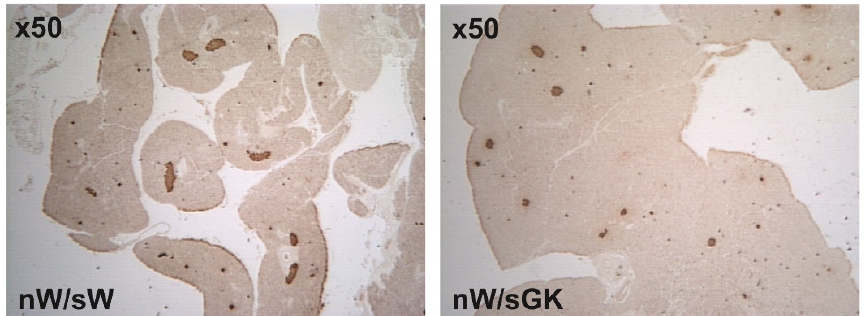
Figure 5. Representative immunoperoxidase staining for pancreatic insulin in 8-wk-old male rats. Animals were issued from W neonates suckled by GK foster mothers (nW/sGK group), or issued from W neonates suckled by W foster mothers (nW/sW group). After glucose administration, their plasma glucose levels and AUC/glucose ( Δ I / Δ G ) raised to levels markedly higher ( p < 0.01) than those in nW/sW males (Figure 4). In re- sponse to glucose, their AUC/insulin( Δ I ) and their mean insulinogenic index ( Δ I / Δ G ) were markedly lower ( p < 0.01) than those in the nW/sW males (Figure 4). A similar pattern was found in 4- and 8-wk-old nW/sGK females raised in parallel, with a mean Δ I insulin and a mean insulinogenic index ( Δ I / Δ G ) markedly lower ( p < 0.01) than those in the nW/sW females (Figure 4). From the data obtained here, we concluded that suckling of a non-diabetic W off- spring by a diabetic GK mother alone is sufficient to significantly increase the risk of in- tolerance to glucose at adult age. 4. Discussion In the current study, we sought to dissect the impact of a diabetic postnatal nutri- tional environment, either alone or in combination with an in utero diabetic environment, on the metabolic phenotype of offspring in adulthood. We followed the phenotype of Wistar rats who were cross-fostered from birth to weaning onto diabetic GK dams (nW/sGK model). At 4 weeks of age (just before weaning), the nW/sGK males exhibited low body weight, low pancreatic insulin content and low beta cell mass. This was associ- ated with low glucose-induced insulin secretion and glucose intolerance, as compared to the normal phenotype (nW/sW model). At 8 weeks of age (young adult), the nW/sGK males had regained normal body weight, but they still suffered low pancreatic insulin content, low beta cell mass, low glucose-induced insulin secretion and glucose intoler- ance. One may conclude that non-diabetic W offspring suckling by a diabetic mother from birth to weaning adversely and irreversibly impacts beta cell mass and is associated with long-term impairment of insulin secretion and glucose tolerance. This conclusion sup- ports the notion first proposed by Patel and Srinivasan [16] that metabolic programming of the endocrine pancreas may occur during the neonatal nutrition period, with their demonstration that artificially rearing rat pups on high-carbohydrate milk during the suckling period induces glucose intolerance and impaired insulin secretion [16,17]. It is clear that an altered growth profile in the postnatal period can affect adult met- abolic homeostasis [18–20]. This is a matter of concern in the nW/sGK model since we